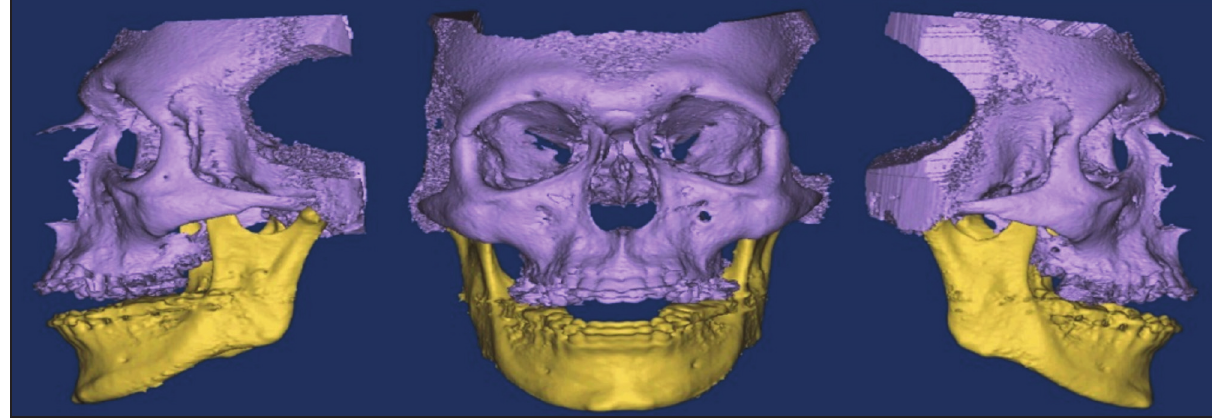
Figure 7. Virtual skull with inaccurate dentition derived from CBCT scan. Note the streak artefacts.